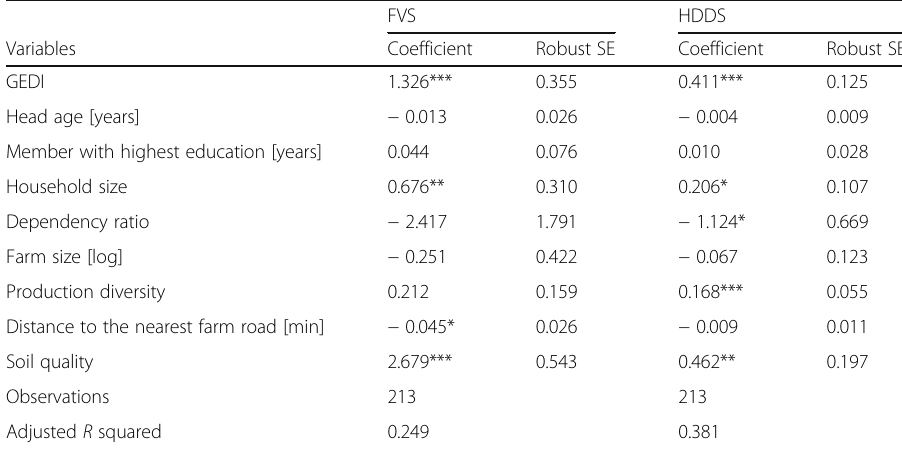
Table 5 Linear estimation of association between gender equality in decision-making and dietary diversity